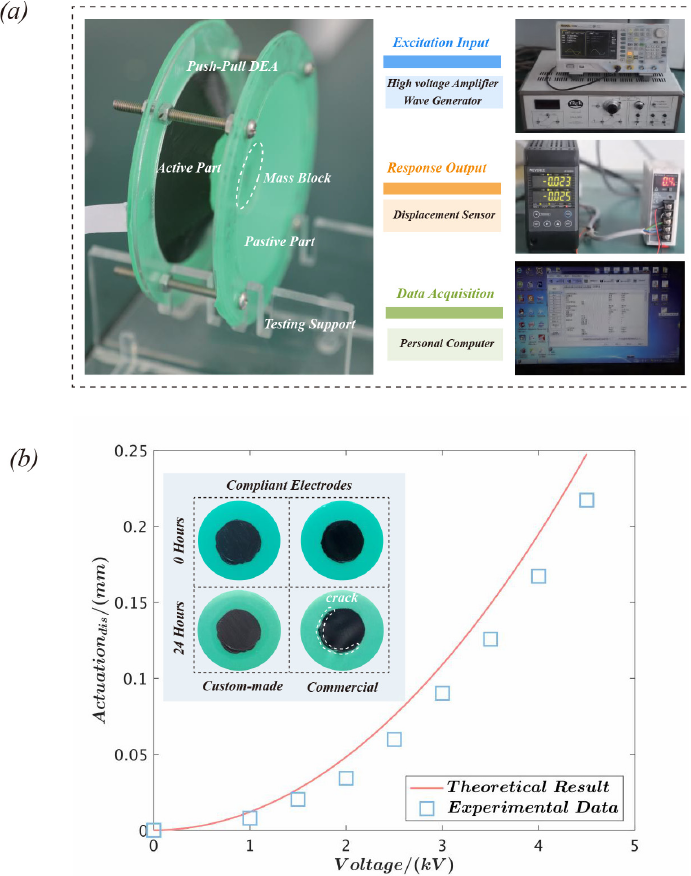
Figure 3. Push-pull DEA performance test and its static response: ( a ) the experimental setup for measuring the actuation performance; ( b ) the actuation displacement of the push-pull DEA at static voltage and comparison with the theoretical results.